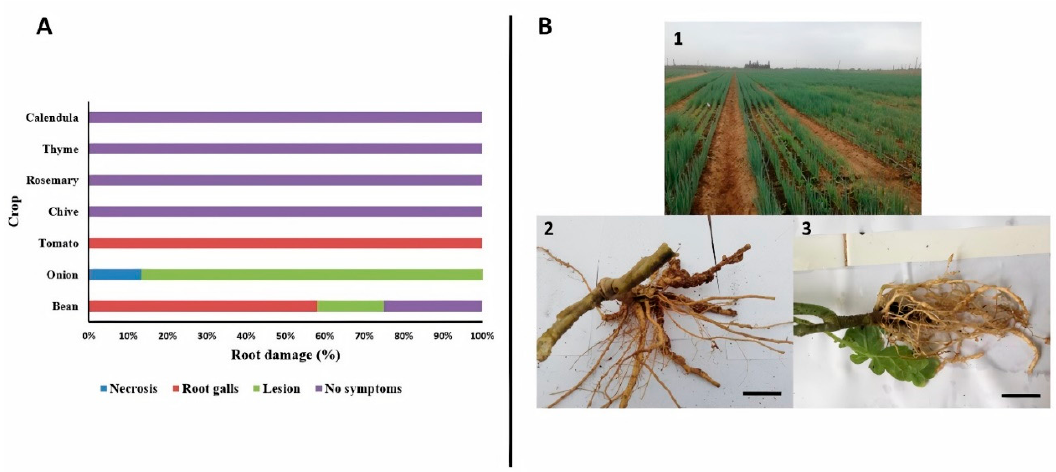
Figure 2. Root damage in samples collected from organic vegetable and medicinal crops in Southern Morocco. ( A ) Percentages of root damages recorded for each organic cropping systems. ( B ) Onion field with symptoms of stunting of growth and yellowing of leaves caused by Pratylenchus spp. ( 1 ), damage (galls) caused by Meloidogyne javanica ( 2 ), and M. incognita ( 3 ) on tomato roots ( Solanum lycopersicum ).